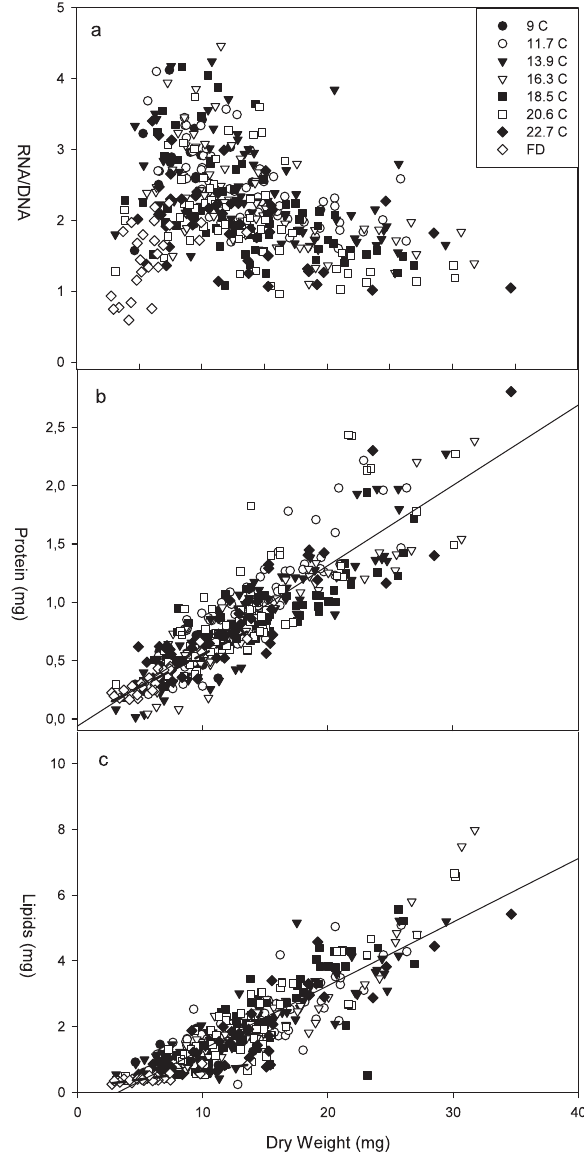
F IG . 1. – Relationship between dry weight and (a) RNA/DNA (b) proteins and (c) lipids for fed fish at 7 different temperatures (overall regression: thin solid line), and food-deprived fish (FD) (regression: dashed thicker line). Regression coefficients for pooled temperatures are given in Table